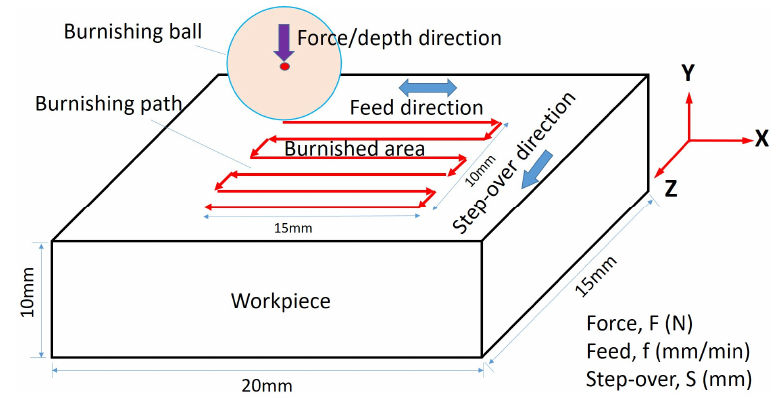
Figure 3. Schematic of burnishing process and tracks.